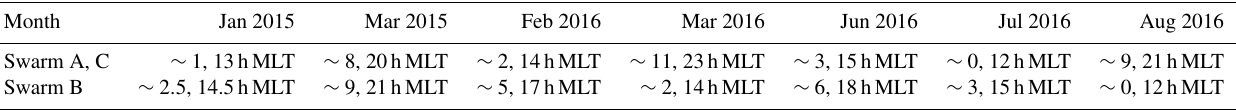
Figure 16. Percentage of screened position in comparison to the F10 . 7 and Kp indices. Table 4. Local time at the middle of the